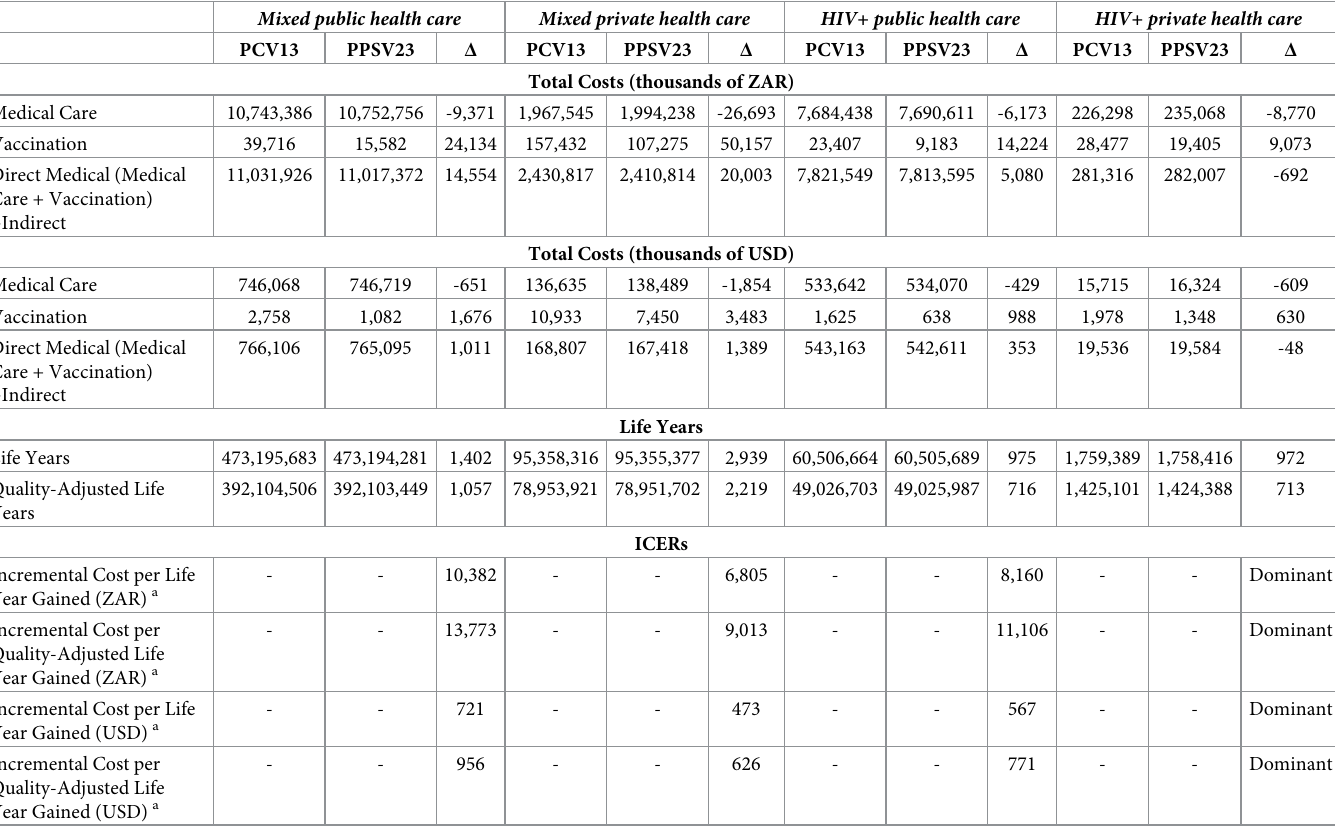
Table 9. Cost-effectiveness of PCV13 versus PPSV23 vaccination in South African adults in the public and private health care settings for the mixed and HIV-posi- tive populations